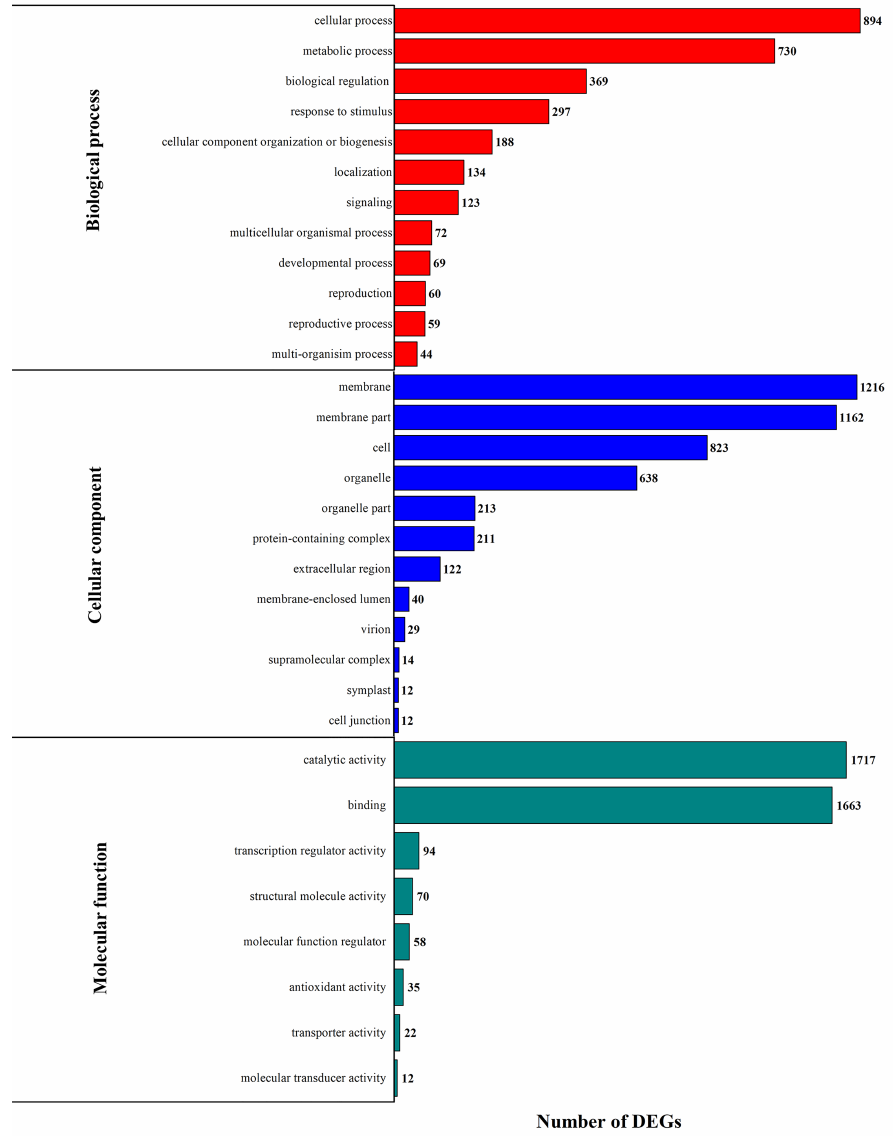
Figure 2. Gene Ontology (GO) analysis between normal pistil (NP) and abortive pistil (AP) showing Figure 1. This is a figure, Schemes follow the same formatting. If there are multiple panels, they should be listed as: ( a ) Description of what is contained in the first the abundance of di ff erentially expressed enriched GO panel. ( b ) Description of what is contained in the second panel. Figures should be placed in the main text near to the first time they are cited. A caption on a single line should be centered.